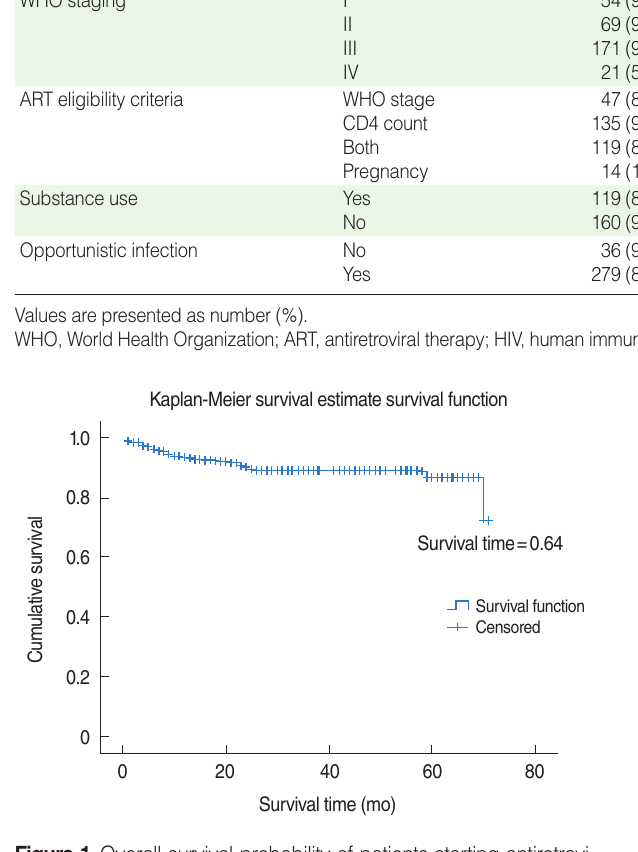
Figure 1. Overall survival probability of patients starting antiretrovi- ral therapy in Jinka Hospital from September 2010 to August 2015.